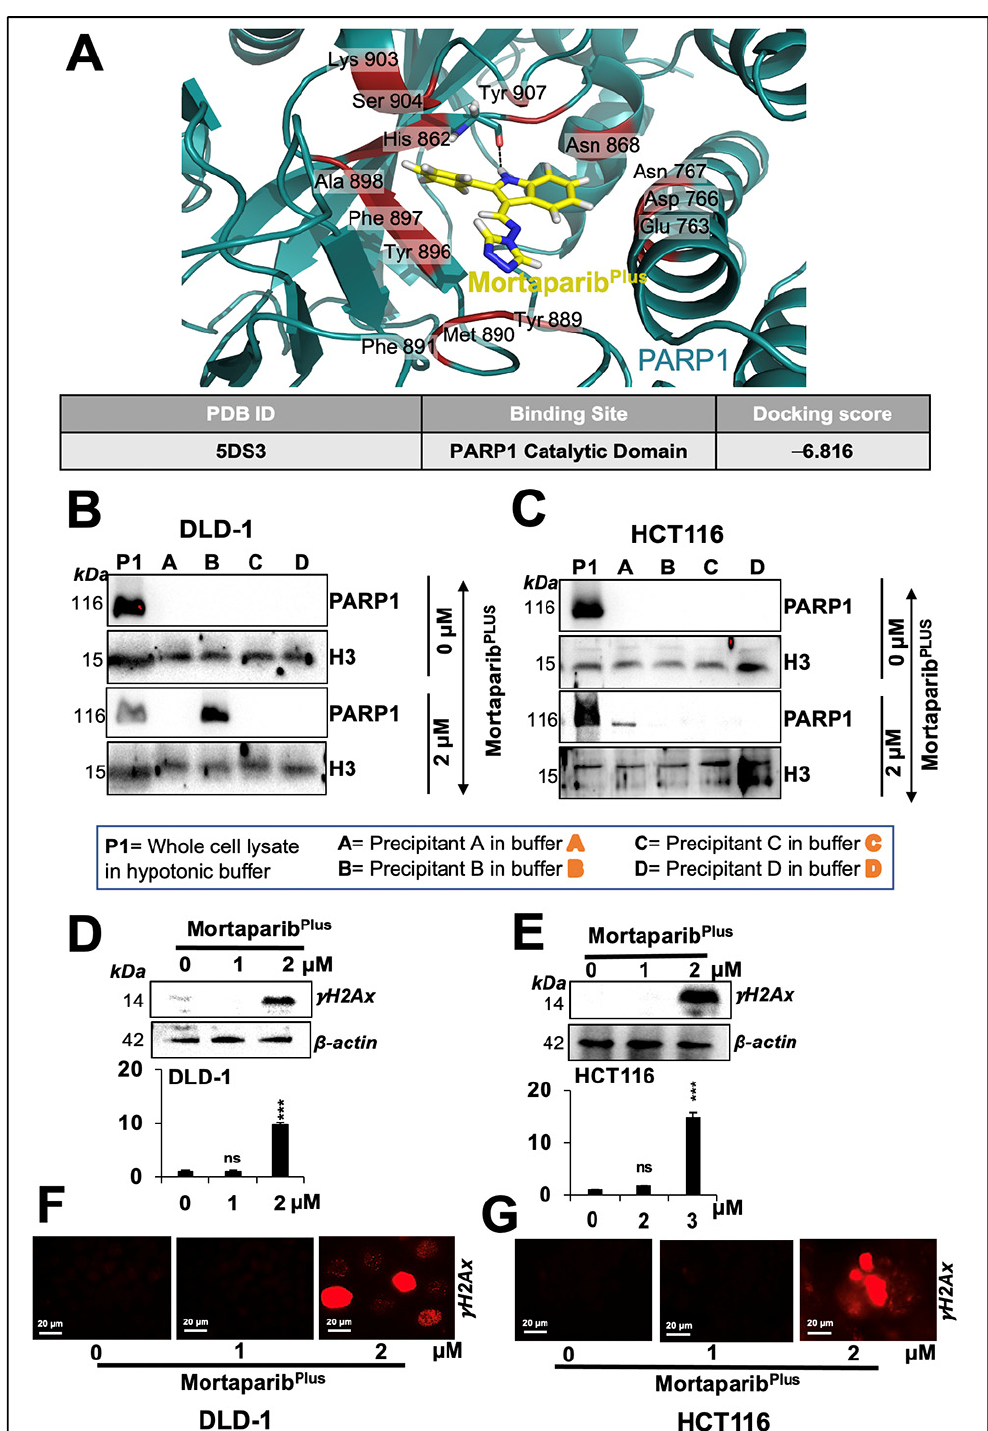
Figure 7. Mortaparib Plus caused inhibition of PARP1 catalytic activity resulting in an impairment of the DNA-damage-repair signalling. Molecular-docking analyses showed an interaction of Mortaparib Plus with PARP1 catalytic domain ( A ). Western-blotting analyses of PARP1-DNA complexes of 24 h Mortaparib Plus -treated colorectal cancer cells showed trapping of PARP1 in DNA ( B , C ). The levels of the phosphorylated H2A histone variant X ( γ H2AX) in control and 24 h Mortaparib Plus -treated cells were analysed by Western blotting ( D , E ) and immuno-cytochemistry ( F , G ) that showed an increase in the number of γ H2AX foci in the treated cells. Scale bar in immuno-cytochemistry equals 20 µ m. The quantified data represents mean ± SD obtained from three independent biological replicates; p -values were calculated using unpaired Student’s t -test *** < 0.001 represent significant, very significant and very very significant, respectively.